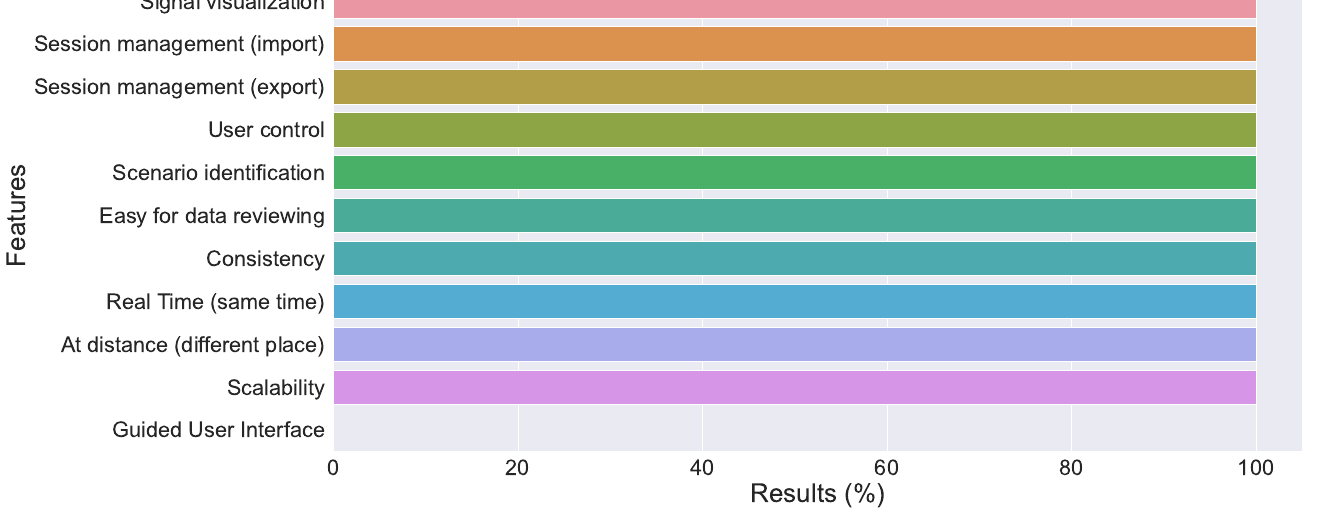
Figure 6. Results depending on each